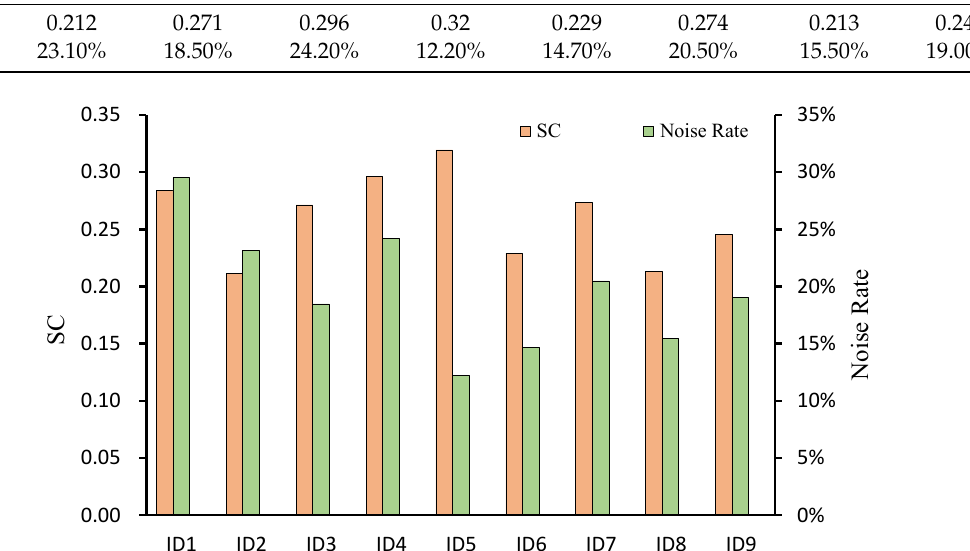
Figure 9. Histogram of SC and noise rate of clustering results of parameter combinations. It can be easily seen from Figure 9 that the SC of ID5 is high and the noise rate is low. Therefore, when Eps is set to 80 and ∆ T is set to 20, the clustering result is the best. Different colors are used to represent different clusters, and the clustering result of this parameter combination is presented in three-dimensional space, as shown in Figure 10.